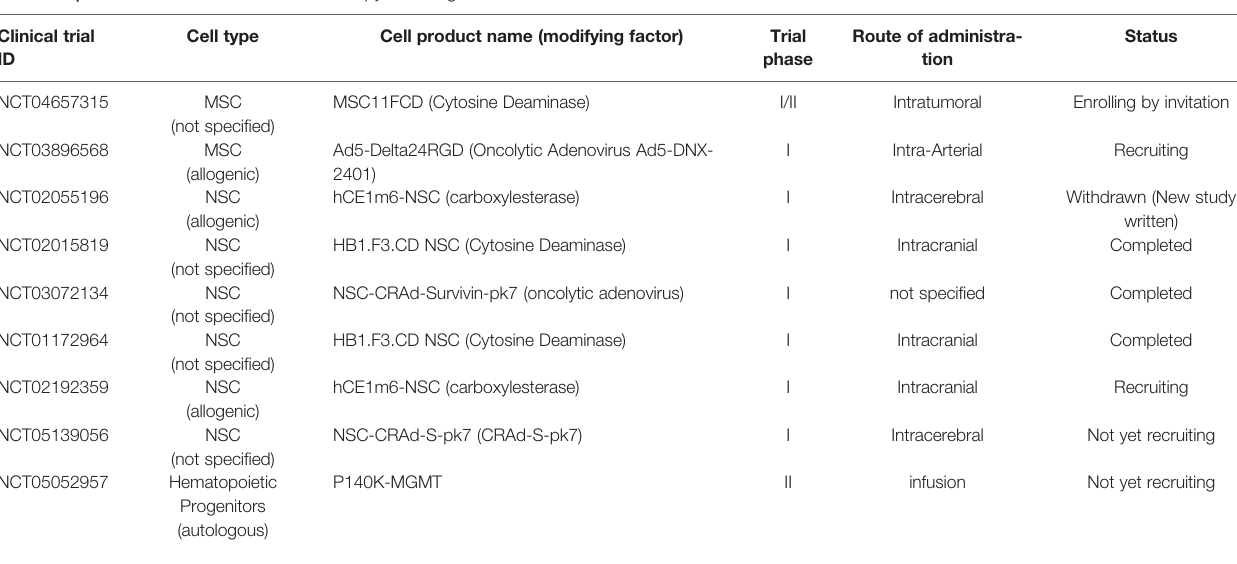
TABLE 2 | Clinical trials of stem cell-based therapy to treat glioblastoma.